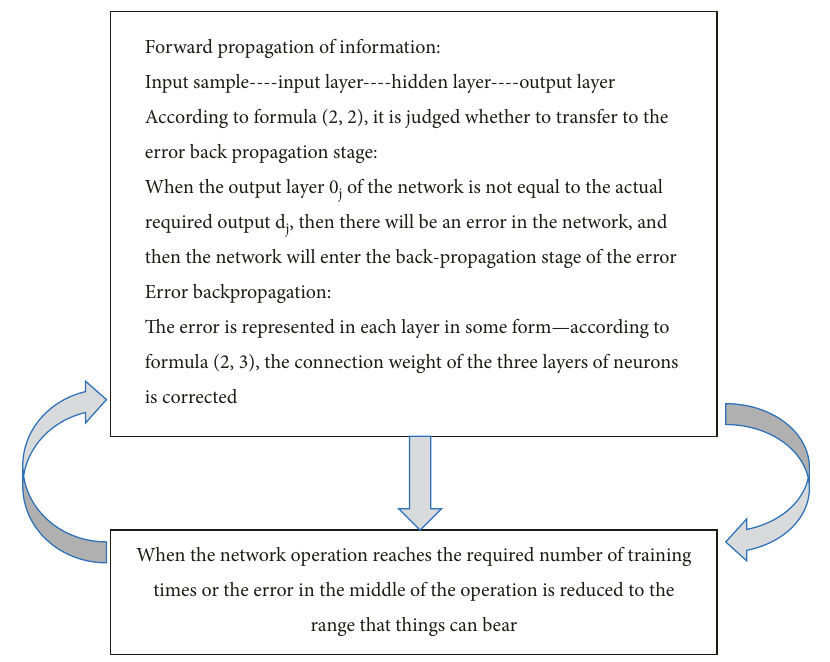
Figure 2: The algorithm idea of BP neural